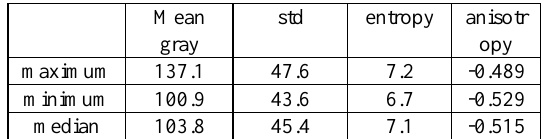
Table 1. Statistical results of descent